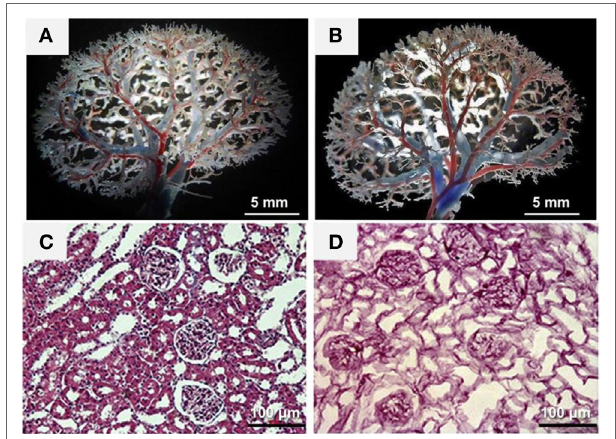
FiGURe 1 | Characterization of the decellularized kidney scaffolds . (A,B) Vascular corrosion casting showed a normal vascular tree of the decellularized kidney scaffold (B) compared with that of the intact kidney (A) . (C,D) H&E staining showed the existence of blue-stained nuclei in the intact kidney (C) but not in the decellularized kidney scaffold (D) . Reprinted and modified with permission from Yu et al.